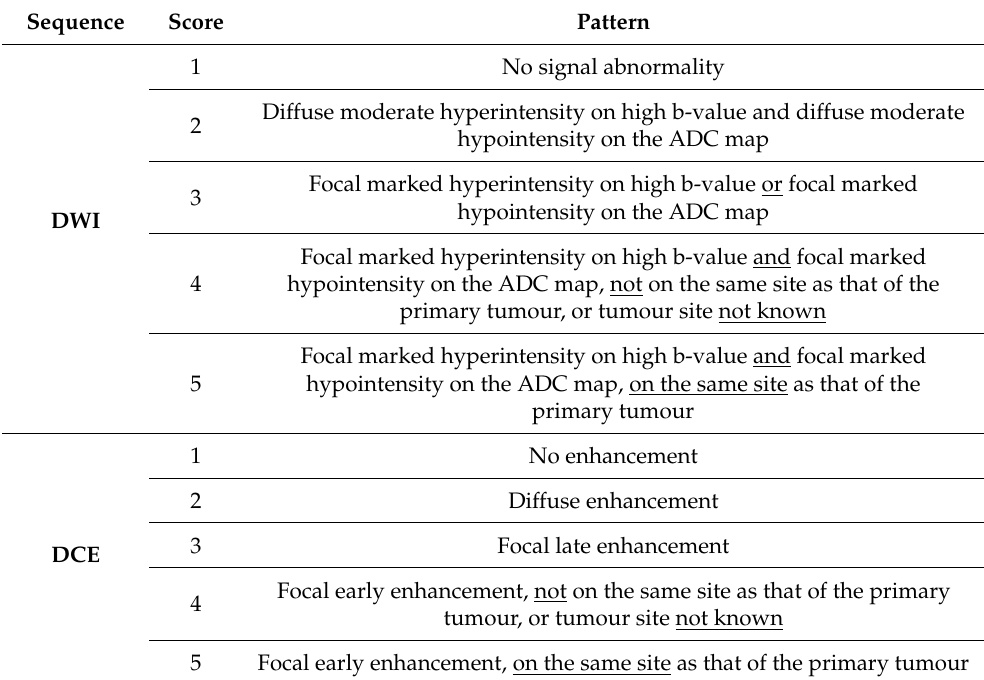
Table 1. Diffusion-weighted imaging (DWI) and dynamic-contrast enhancement (DCE) score assessment. Sequence Score Pattern 1 No signal abnormality Diffuse moderate hyperintensity on high b-value and diffuse moderate 2 hypointensity on the ADC map Focal marked hyperintensity on high b-value or focal marked 3 hypointensity on the ADC map DWI Focal marked hyperintensity on high b-value and focal marked 4 hypointensity on the ADC map, not on the same site as that of the primary tumour, or tumour site not known Focal marked hyperintensity on high b-value and focal marked 5 hypointensity on the ADC map, on the same site as that of the primary tumour 1 No enhancement 2 Diffuse enhancement 3 Focal late enhancement DCE Focal early enhancement, not on the same site as that of the primary 4 tumour, or tumour site not known